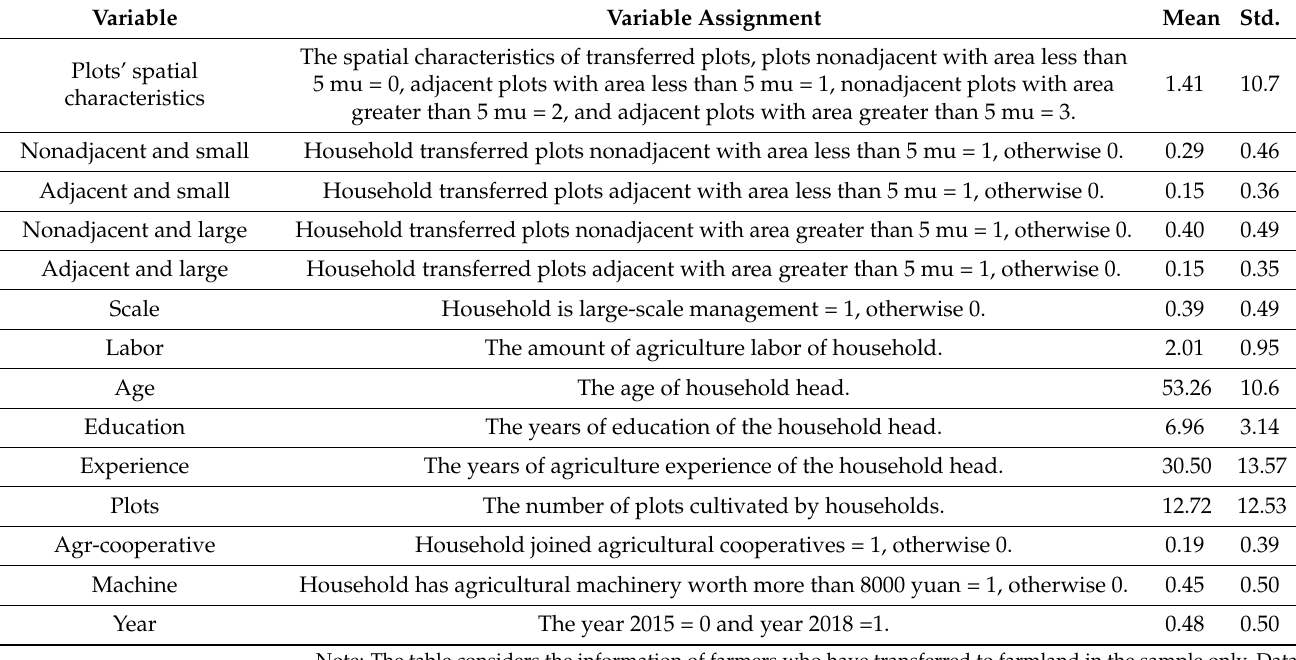
Table 2. Variable definitions and descriptive